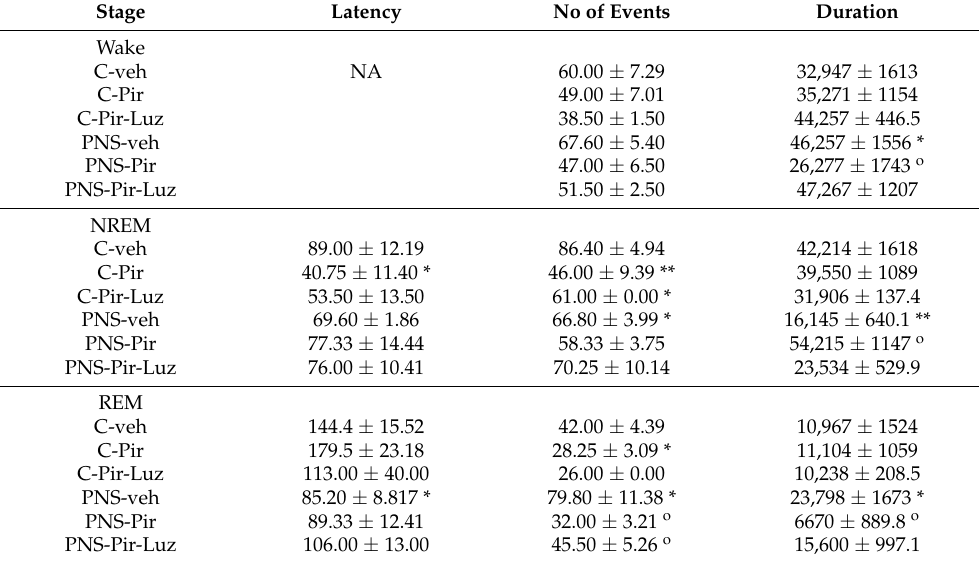
Table 2. Female rats: The latencies to onset of non-REM (NREM) sleep and rapid eye movement (REM) sleep, number and duration of Wake events, NREM and REM in controls treated with vehicle (C-veh), controls treated with Piromelatine (Pir) (C-Pir), controls treated with Pir + luzindol (Luz) (C-Pir-Luz), rats exposed to prenatal stress (PNS) and treated with vehicle (PNS-veh), rats exposed to PNS and treated with Pir (PNS-Pir) and rats exposed to PNS and treated with Pir + Luz (PNS-Pir-Luz). Stage Latency No of Events Duration Wake C-veh